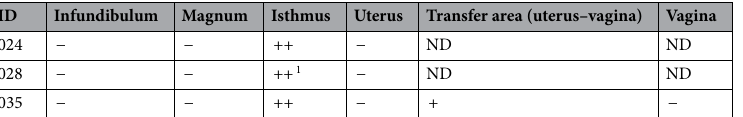
Table 2. Location of sperm in glands of oviducts collected from green turtles. Absent (−), some (+), and many (++) glands containing sperm. ND not determined. 1 Abundant sperm on epithelial